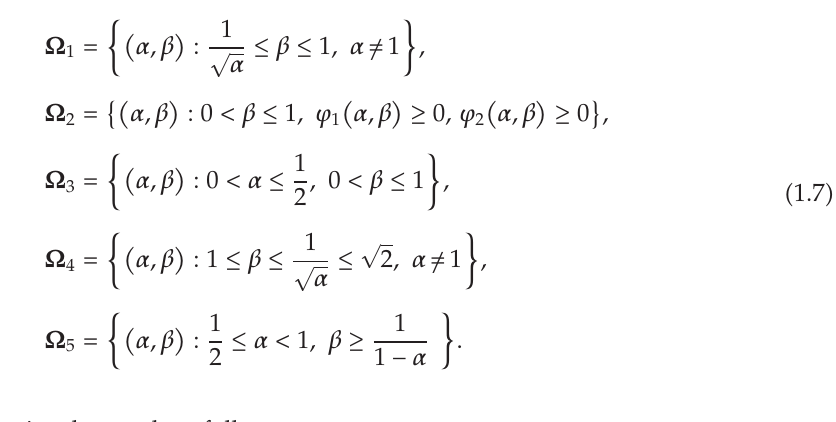
For convenience, we need to define five subsets of (cid:2) 0 , ∞ (cid:3) × (cid:2) 0 , ∞ (cid:3) and refer to Figure